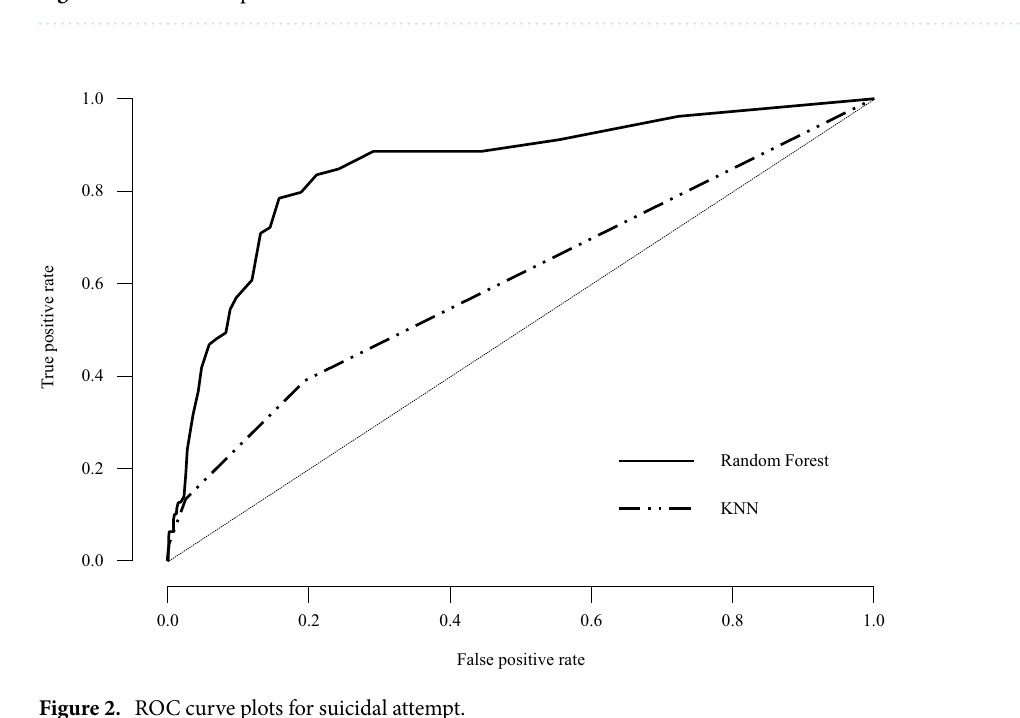
Figure 2. ROC curve plots for suicidal